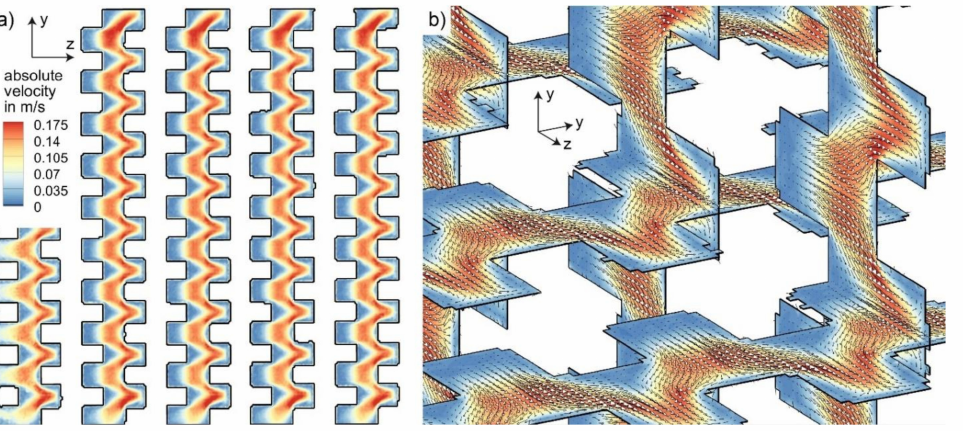
Figure 5. Velocity field obtained with the highest resolution of 0.42 mm: ( a ) selected slice; ( b ) 3-dimensional view including velocity